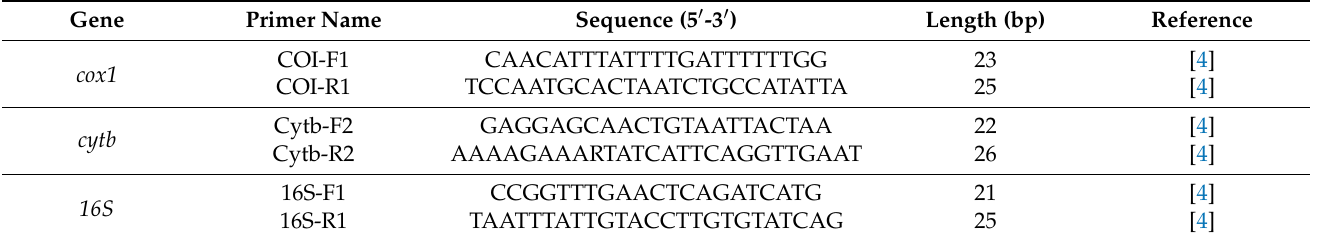
Table 1. Primers used in this